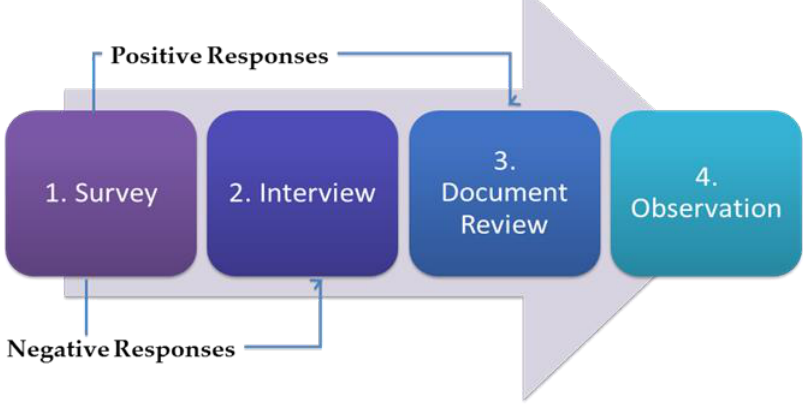
Figure 1.Sequence of implementing the data collection methods.